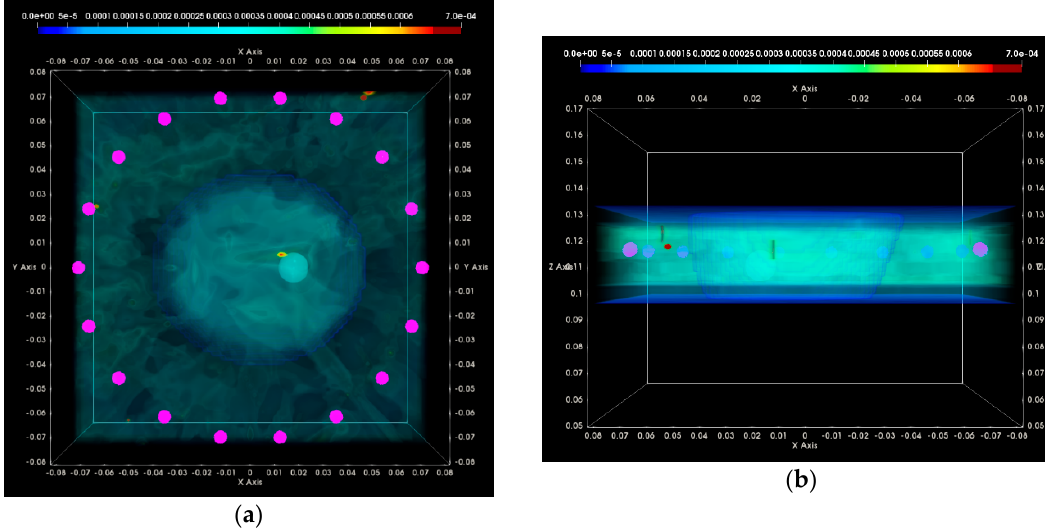
Figure 25. Breast rotational position #1—Test Date 2—image formed using six vertical positions of the sensor network, in the vicinity of the tumor—image in the interior of the breast superimposed with the image of the full imaging domain: ( a ) top XY view; ( b ) side XZ view.